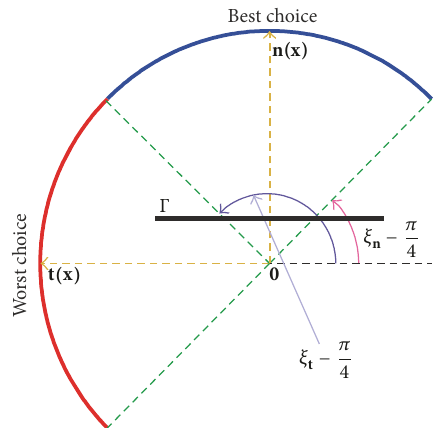
Figure 2: Description of best (blue-colored range) and worst (red-colored range) choice of the range of incident directions.